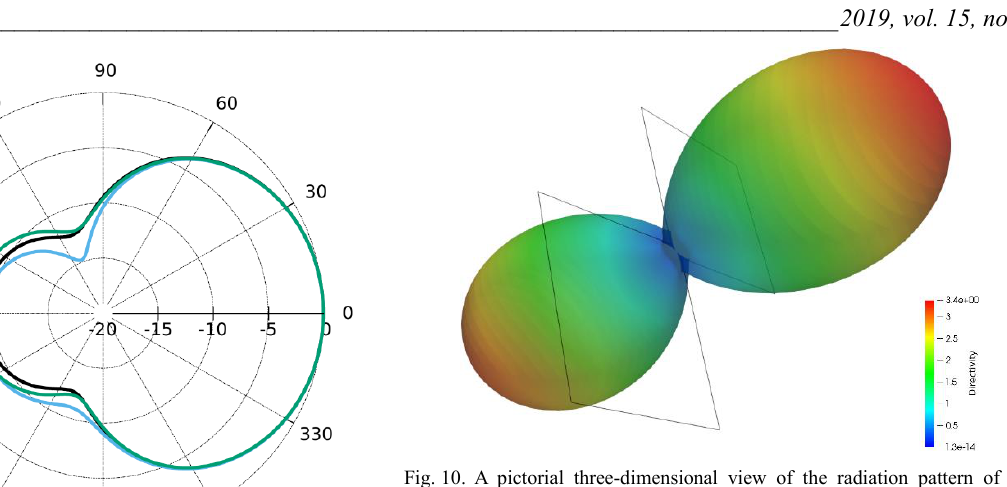
Fig. 10. A pictorial three-dimensional view of the radiation pattern of the BiQuad antenna. The picture was extracted from the OpenEMS simulation, by using Paraview. Directivity is in linear scale.